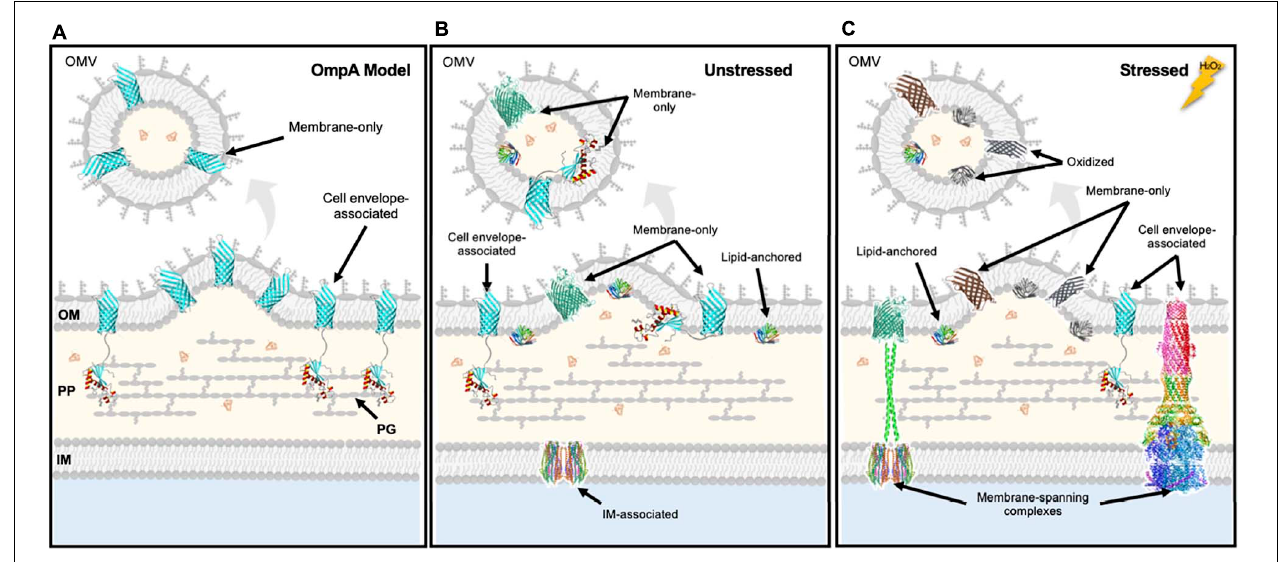
FIGURE 6 | Summary for the selective OMV packaging of untethered cargo into OMVs in unstressed and stressed conditions. (A) Results from studying the packaging of OmpA constructs revealed that cell envelope-associated (full-length) cargo tend to be retained whereas membrane only (truncated) cargo tend to enter OMVs. Results from studying selective native cargo OMV packaging during unstressed (B) and stressed (C) conditions revealed that the ability of proteins to tether to the cell envelope is a determinant for incorporation as OMV cargo. Integral OM proteins engaged in cell envelope complexes which increase cellular efflux and nutrient import are preferentially retained in the membrane after stress, maybe whereas oxidized proteins as well as untethered OM proteins will be preferentially exported into OMVs. OM, outer membrane; IM, inner membrane; PP, periplasm; PG, peptidoglycan. OmpA structure from Ishida et al. (2014); AcrAB-TolC by Wang et al. (2017); LolB (lipoprotein), PDB 1IWM; TonB extensions modeled from PDB 1JCD; ExbB/ExbD from PDB 5ZFV; FhuA from PDB 2GRX; OmpX from PDB